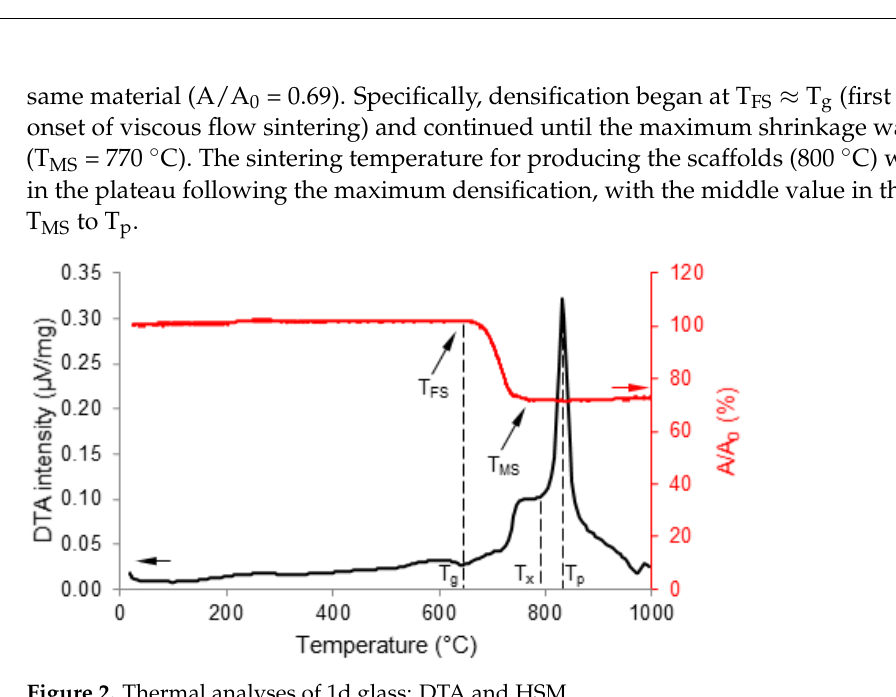
Figure 2. Thermal analyses of 1d glass: DTA and HSM.